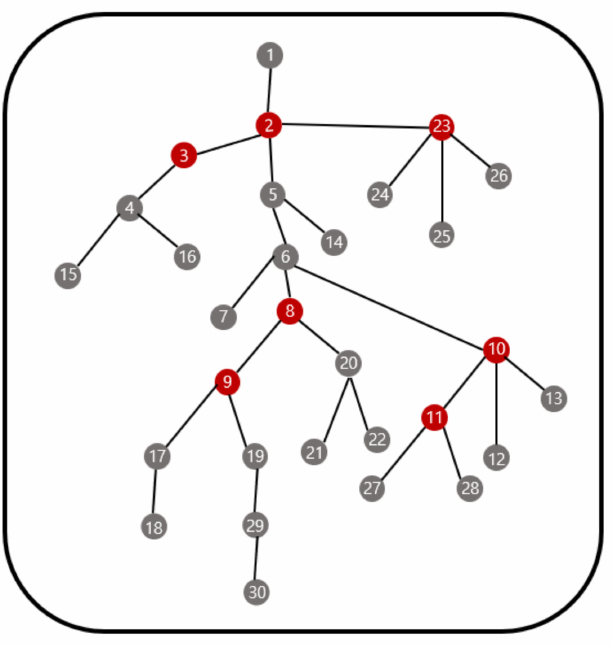
Figure 13. Gateway deployment by the proposed